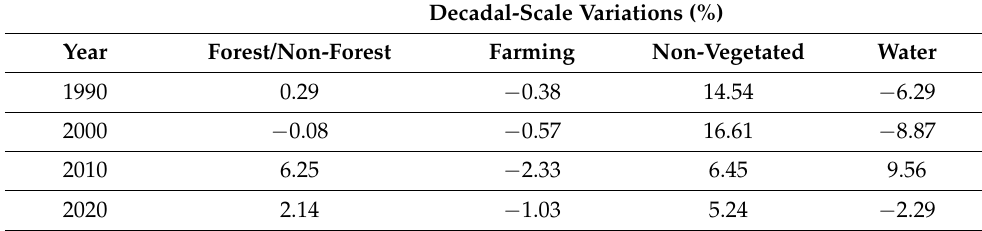
Table 2. Land use and land cover (LULC) variations in the Para í ba do Sul hydrographic basin (PSHB) for 10-year interval